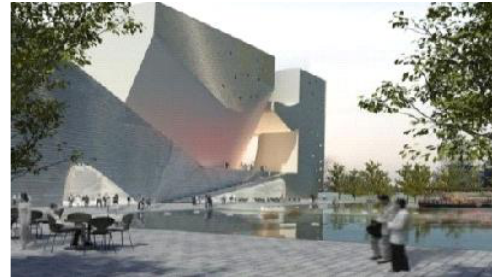
Fig. 9: Ying-Yang museum (3D). (Phaidon, 2016)